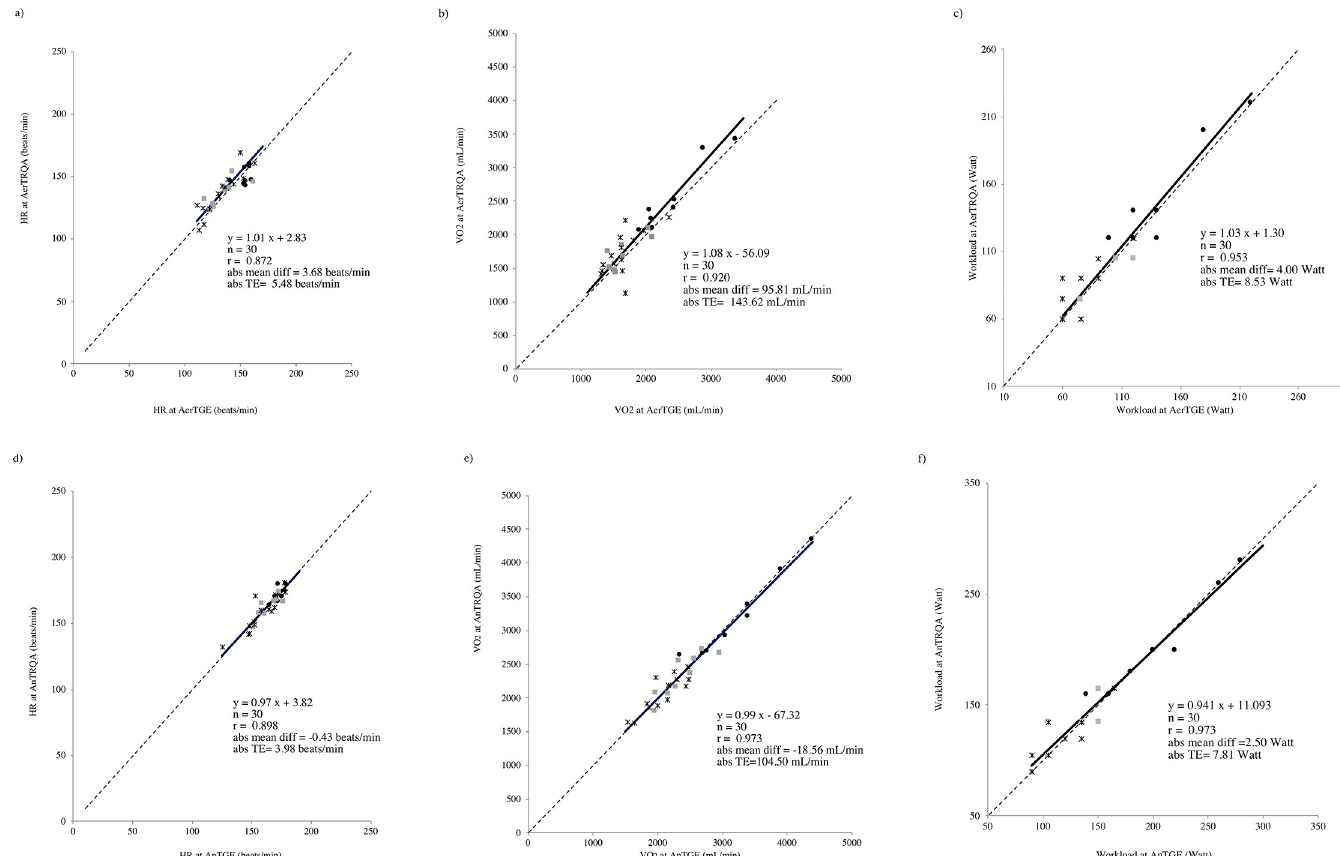
Fig 2. Regression plots of HR, VO2 and workload (first, second and third line, respectively) estimated by RQA and GE methods at AerT (left) and AnT (right). Group A (black circle), group B (grey square) and group C (black star).